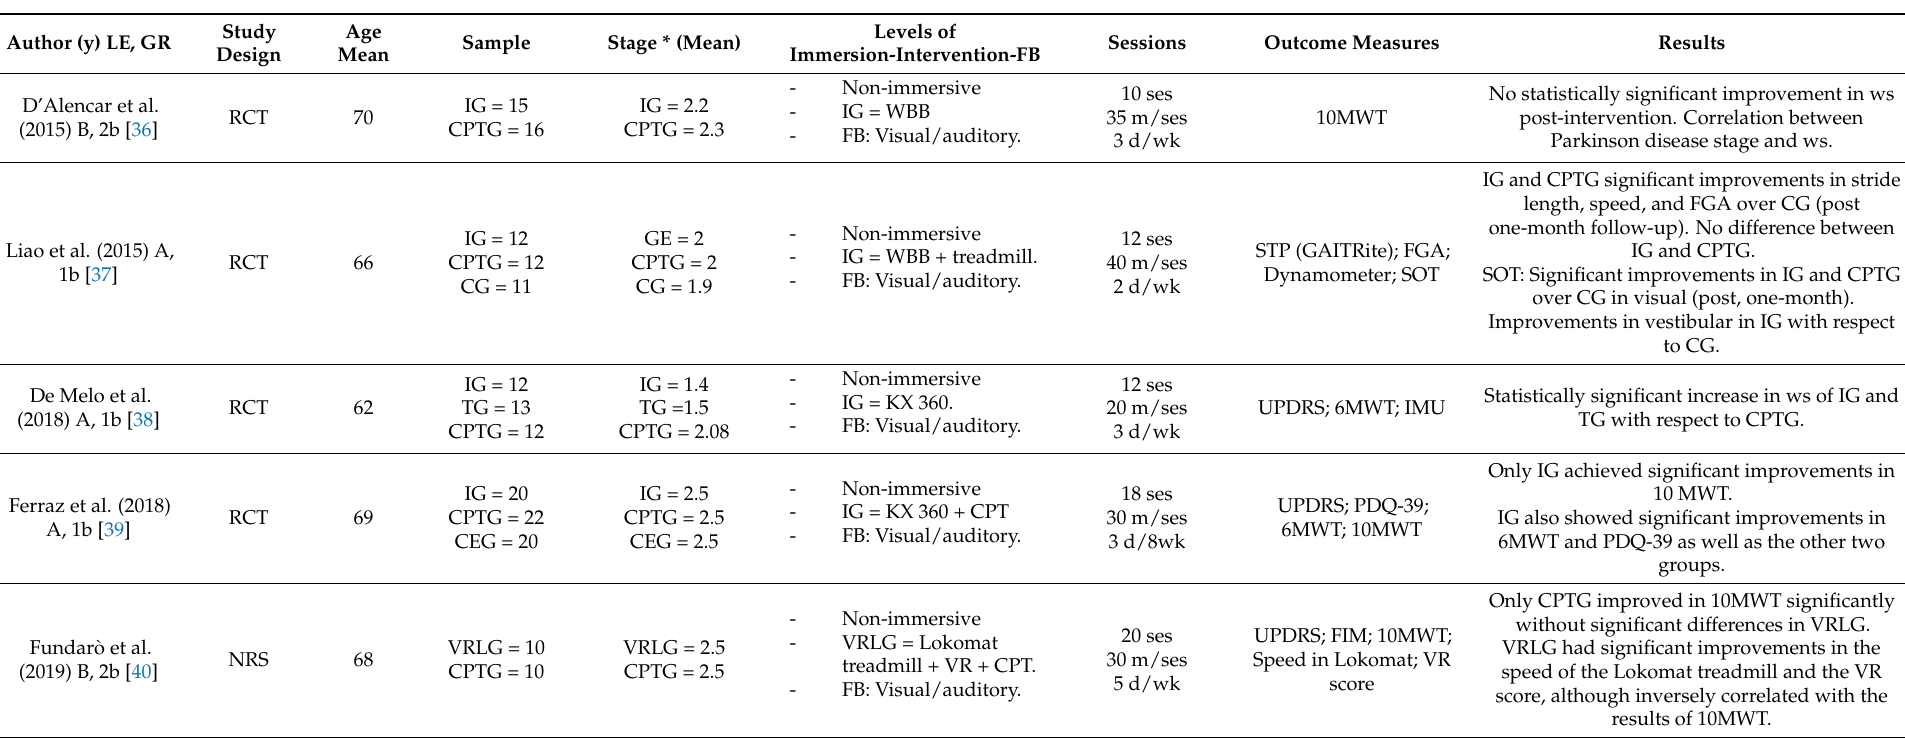
Table 3. Synthesis of